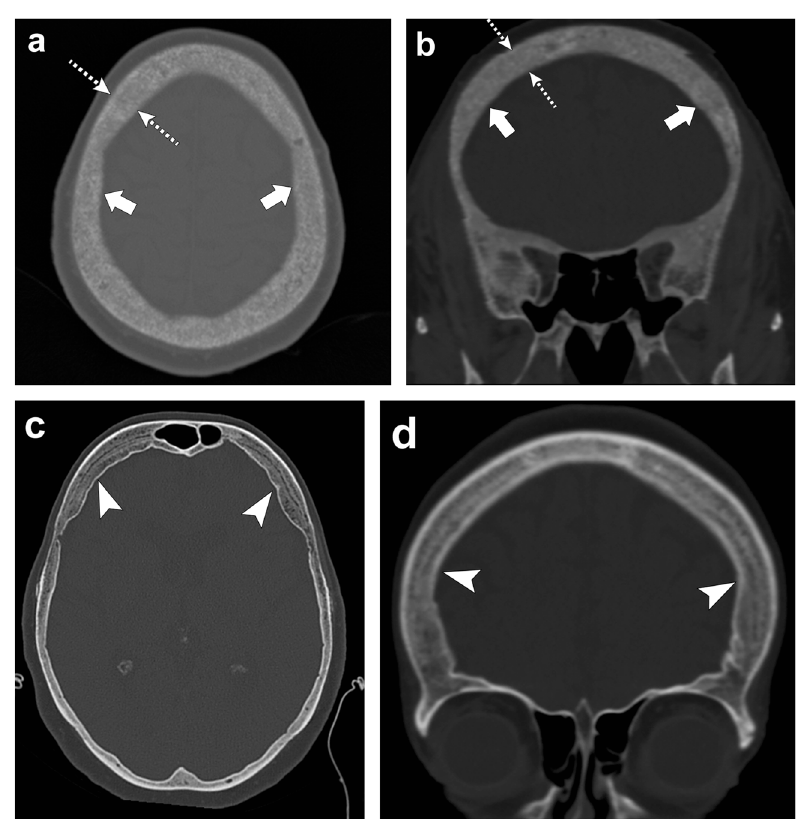
Fig. 22 Renal osteodystrophy and osteopenia. Patient 1: Axial ( a ) and coronal ( b ) head CT images depict granular de- ossification with a B pepper pot ^ appearance ( thick arrows ) and loss of distinction of the inner and outer tables ( dashed arrows ) in this patient with renal osteodystrophy. Patient 2: Axial ( c ) and coronal ( d ) head CT images show demineralisation of the skull ( arrowheads ) in this patient with osteopenia. Note the relative preservation of the distinction of the inner and outer tables in